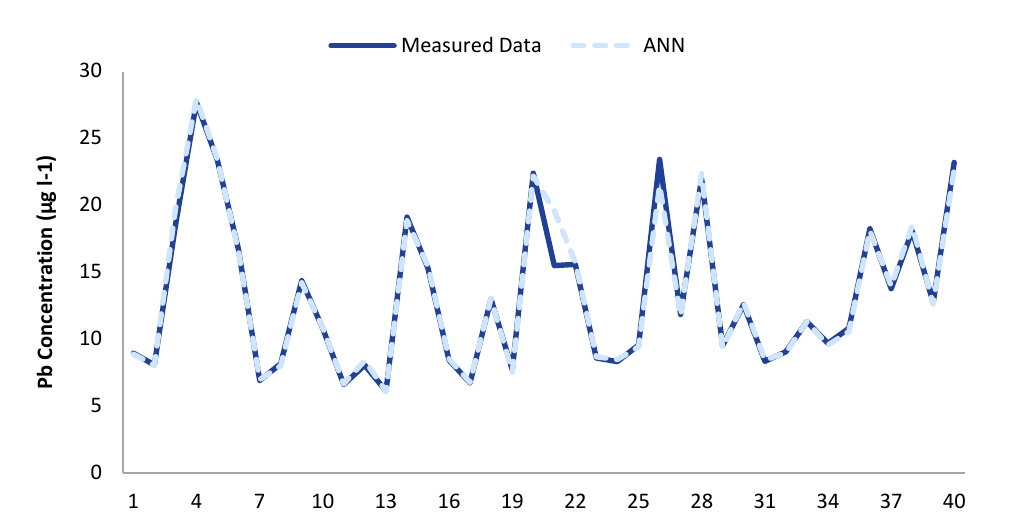
Figure 4. Comparison of the actual groundwater heavy metal concentration values and those predicted for Pb in testing phase ANN: Artificial neural network